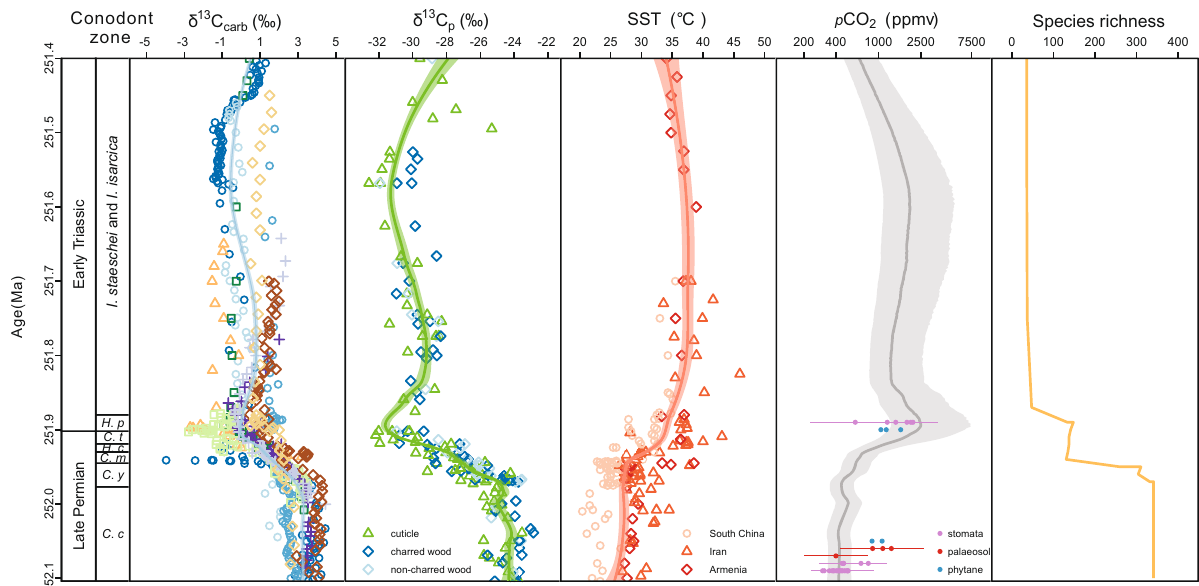
Fig. 3 Summary of Permian – Triassic boundary proxy data and reconstructed p CO 2 changes. The radiometric ages are from the Meishan section 30 . Conodont zones are those of the Meishan section. Global marine carbonate carbon isotope ( δ 13 C carb ) compiled from ten sections (Methods). Land C 3 plant carbon isotopes pro fi le ( δ 13 C p ) is from the four study sections in southwestern China (Fig. 1). Sea surface temperature (SST) was calculated based on conodont δ 18 O values from South China (Meishan and Shangsi) 1 – 3 , Iran (Kuh-e-Ali Bashi and Zal) 4 and Armenia (Chanakchi) 5 . The blue, green and red lines represent the LOESS fi t curve for δ 13 C carb , δ 13 C p and SST, respectively, while light blue, green, and red shaded area represent 68% con fi dence intervals (standard errors calculated from LOESS). Reconstruction of atmospheric p CO 2 based on carbon isotope fractionation in C 3 land plant (on a log scale). Median values of the 10,000 re-samplings determined by Monte Carlo uncertainty propagation are shown as dark gray line. The 68% con fi dence intervals for p CO 2 are showed as light gray shaded area (lower limit and upper limit represent the 16 th and 84 th percentiles respectively). Previous reported p CO 2 estimates based on stomata 16,17 , palaeosol carbonates 13,14 and phytane 15 are shown as points with error bar (Supplementary Table 2). Marine species richness data show the two pulse mass extinction 8 . I . ― Isarcicella ; C. c ― Clarkina changxingensis ; C. y ― Clarkina yini ; C. m ― Clarkina meishanensis